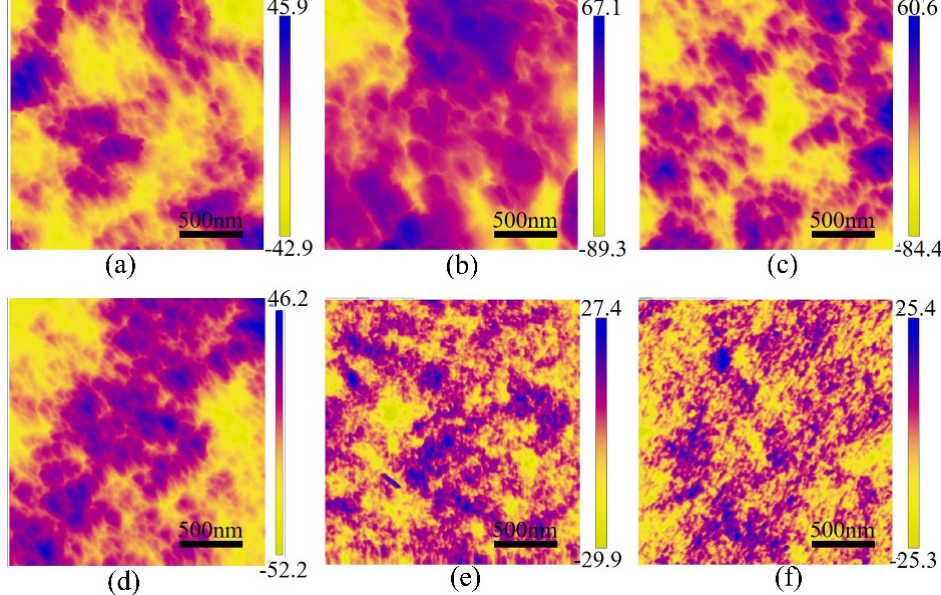
Figure 4. AFM images for the supports: ( a ) support-0, ( b ) support-1, ( c ) support-2, ( d ) support-3, ( e ) support-4, ( f ) support-5. Table 4. Surface roughness parameters and surface porosity of CA/PVDF membranes obtained from AFM and SEM images.